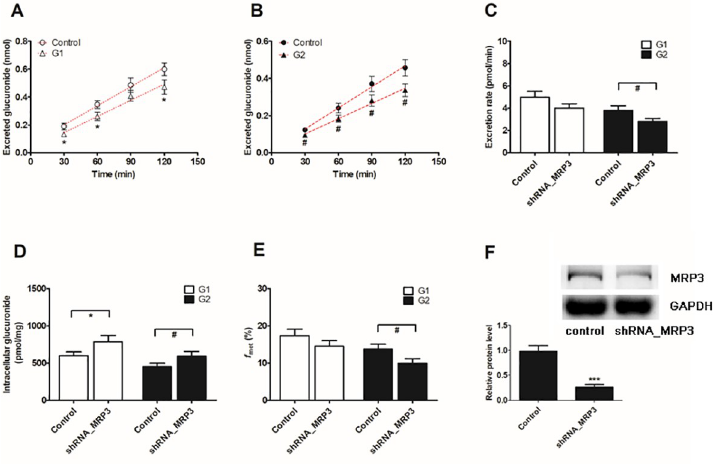
Fig 10. MRP3 silencing led to reduce excretion rates and increase intracellular demethoxycurcumin- O - glucuronides in HeLa1A1 cells. (A) MRP3 transporter silencing inhibited the accumlated demethoxycurcumin- O - glucuronides (G1) in extracellular medium; (B) MRP3 transporter silencing decreased the excreted demethoxycurcumin- O -glucuronides (G2) in extracellular solution; (C) MRP3 silencing significantly reduced the excretion rates of G1 and G2; (D) MRP3 silencing resulted in evaluation of intracellular G1 and G2 levels; (E) MRP3 silencing decreased total cellular glucuronidation (G1 ang G2) of demethoxycurcumin; (F) Effects of gene silencing on the protein level of MRP3. The concentration of demethoxycurcumin was 4 μ M. All experiments were performed in triplicate (n = 3). Data were presented as mean ± SD. � , # p < 0.05, �� , ## p < 0.01 and ��� , ### p < 0.001 compared with that of control group of G1 or G2,